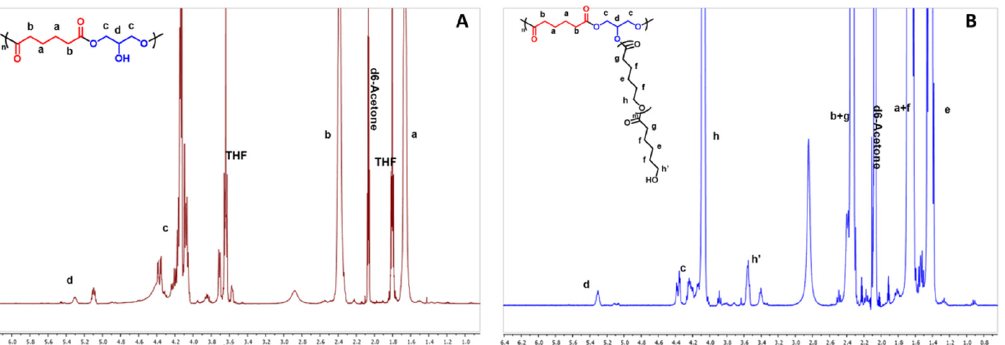
Figure 1. 1 H ‐ NMR spectra of PGA ( A ) and PGA ‐ g ‐ PCL25 ( B ). Only the linear structure of PGA has Figure 1. 1 H-NMR spectra of PGA ( A ) and PGA-g-PCL25 ( B ). Only the linear structure of PGA has been reported for sake of clarity: full structure reported in Scheme 1. been reported for sake of clarity: full structure reported in Scheme